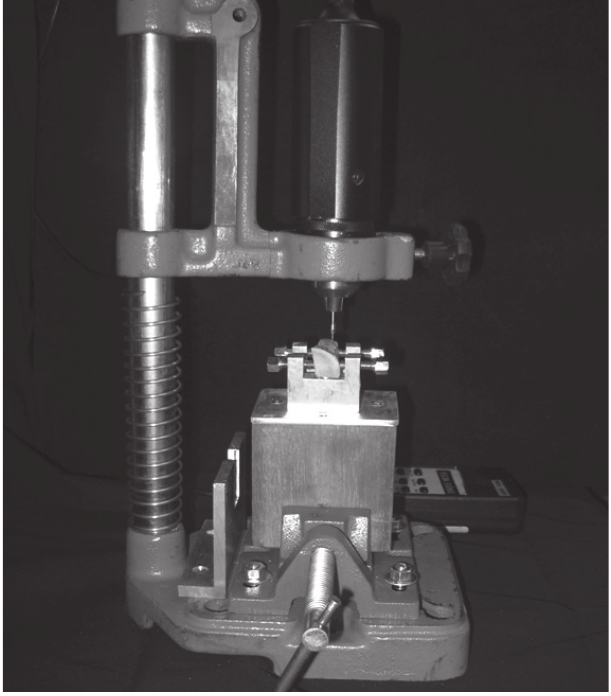
Figure 1. Photograph of the fracture test device showing a digital torque gauge attached to it and bone segment positioned.